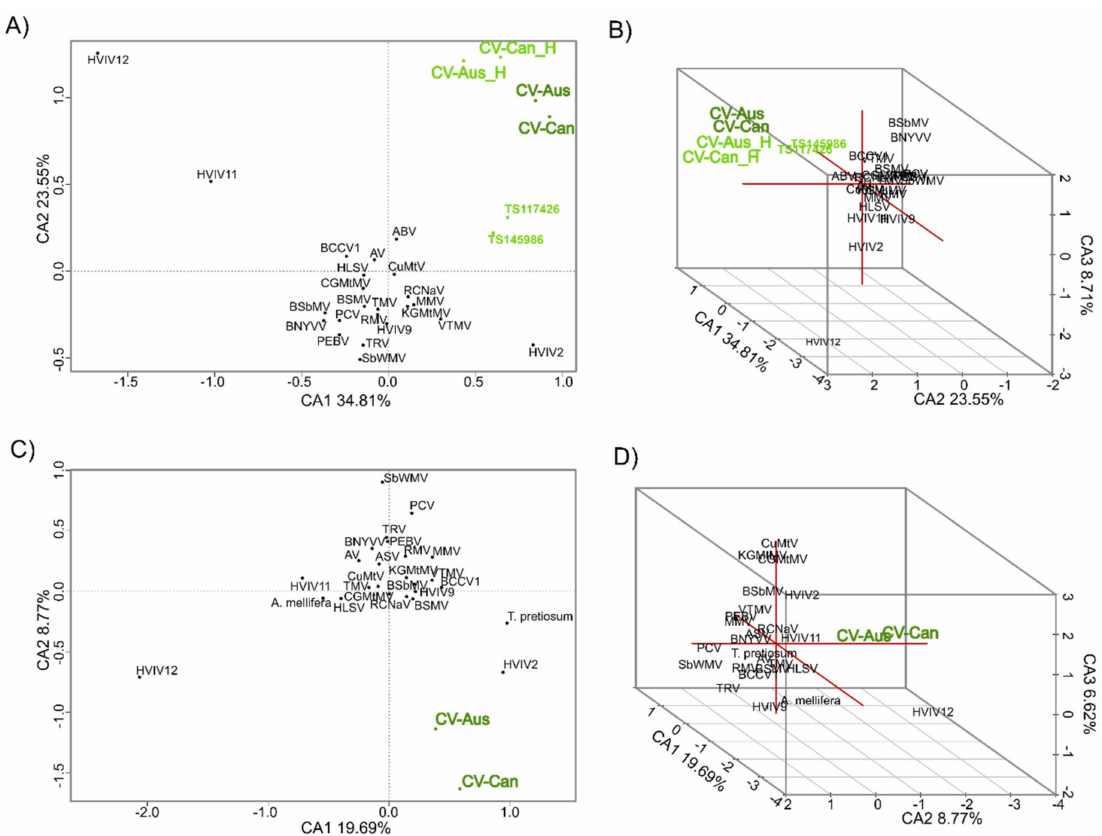
Figure 4. Correspondence analysis of tetra-nucleotide patterns of charaviruses and other sequence related viruses. Patterns were obtained for both RdRp sequences ( A , B ) used in Figure 1, and capsid gene sequences ( C , D ) from Figure 2. The separated helicase sequences of the two charaviruses (CV-Aus_H and CV-Can_H) were included to compare with the helicase sequences reported by [7], but can be seen to be distinct.